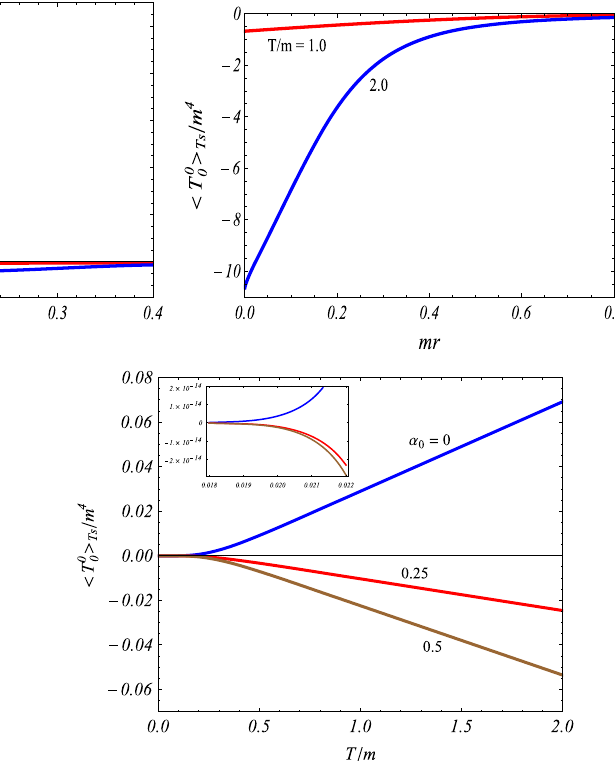
Fig. 4 Thethermalenergydensitycontributioninducedbythestringis plotted for D = 3 as a function of the ratio T / m , with fixed parameters q = 2 . 5, | ˜ μ | / m = 0 . 5, mr = 1 and ξ = 0. Numbers near the curves correspond to different values of α